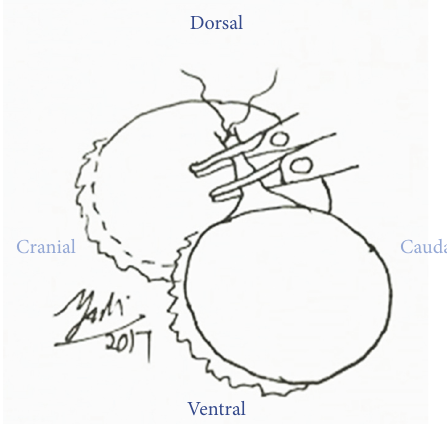
Figure 5: A ring block was made by using 5 mL of lidocaine to infiltrate and desensitize the periocular skin. This served as local block as well as short term local analgesia.